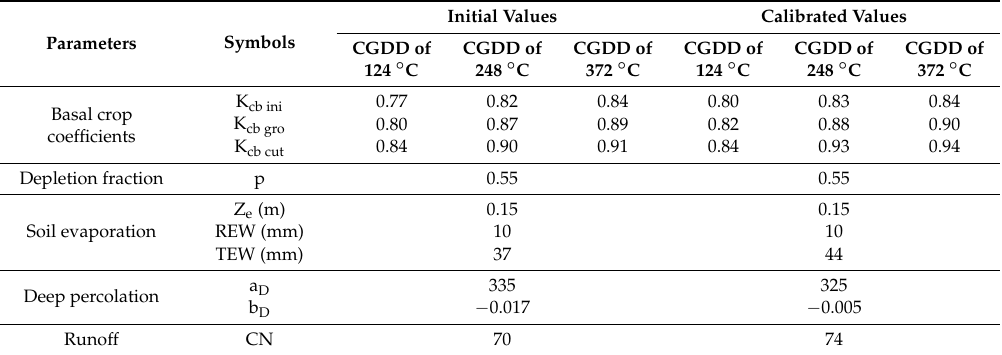
Table 5. Initial and calibrated parameters of SIMDualKc relative to the three treatments of Tifton 85 bermudagrass having different frequency of